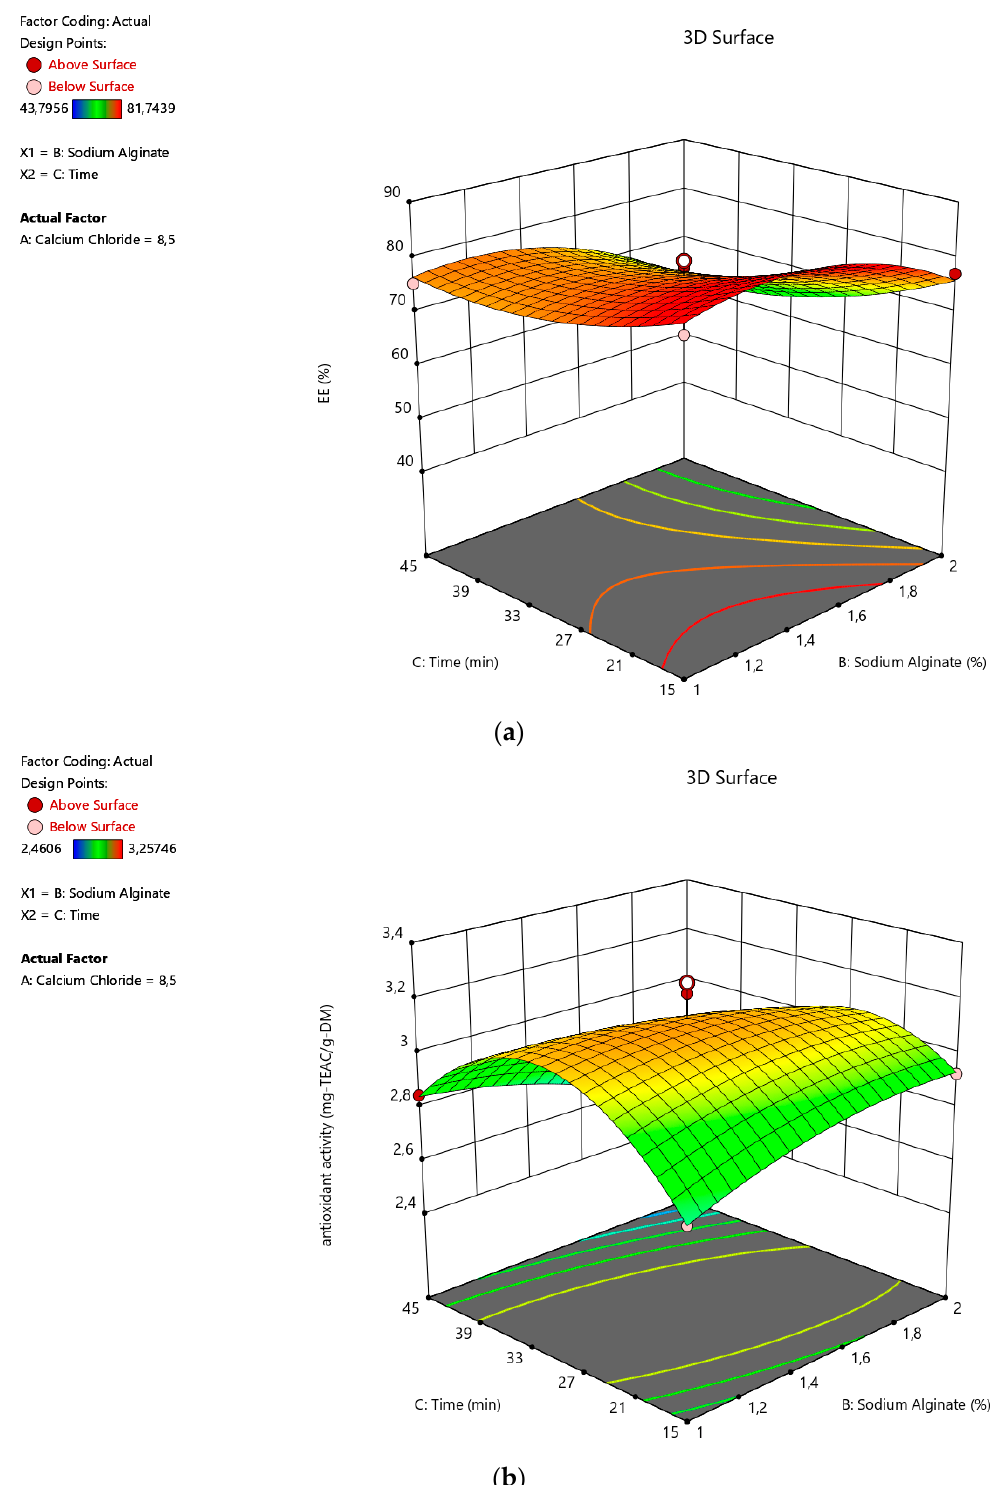
Figure 3. Effects of alginate concentration with time on the ( a ) encapsulation efficiency and ( b ) antioxidant activity of the alginate microcapsules containing active the substances from sour cherry peel extract.